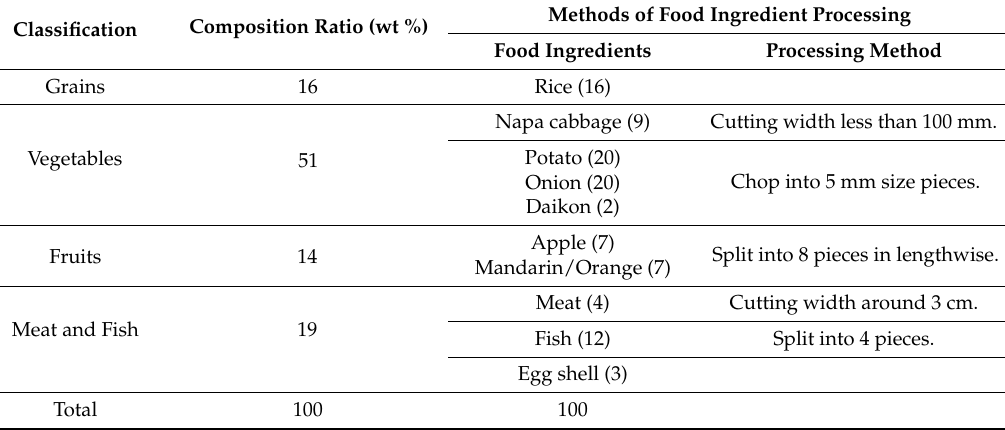
Table 1. The standard food waste